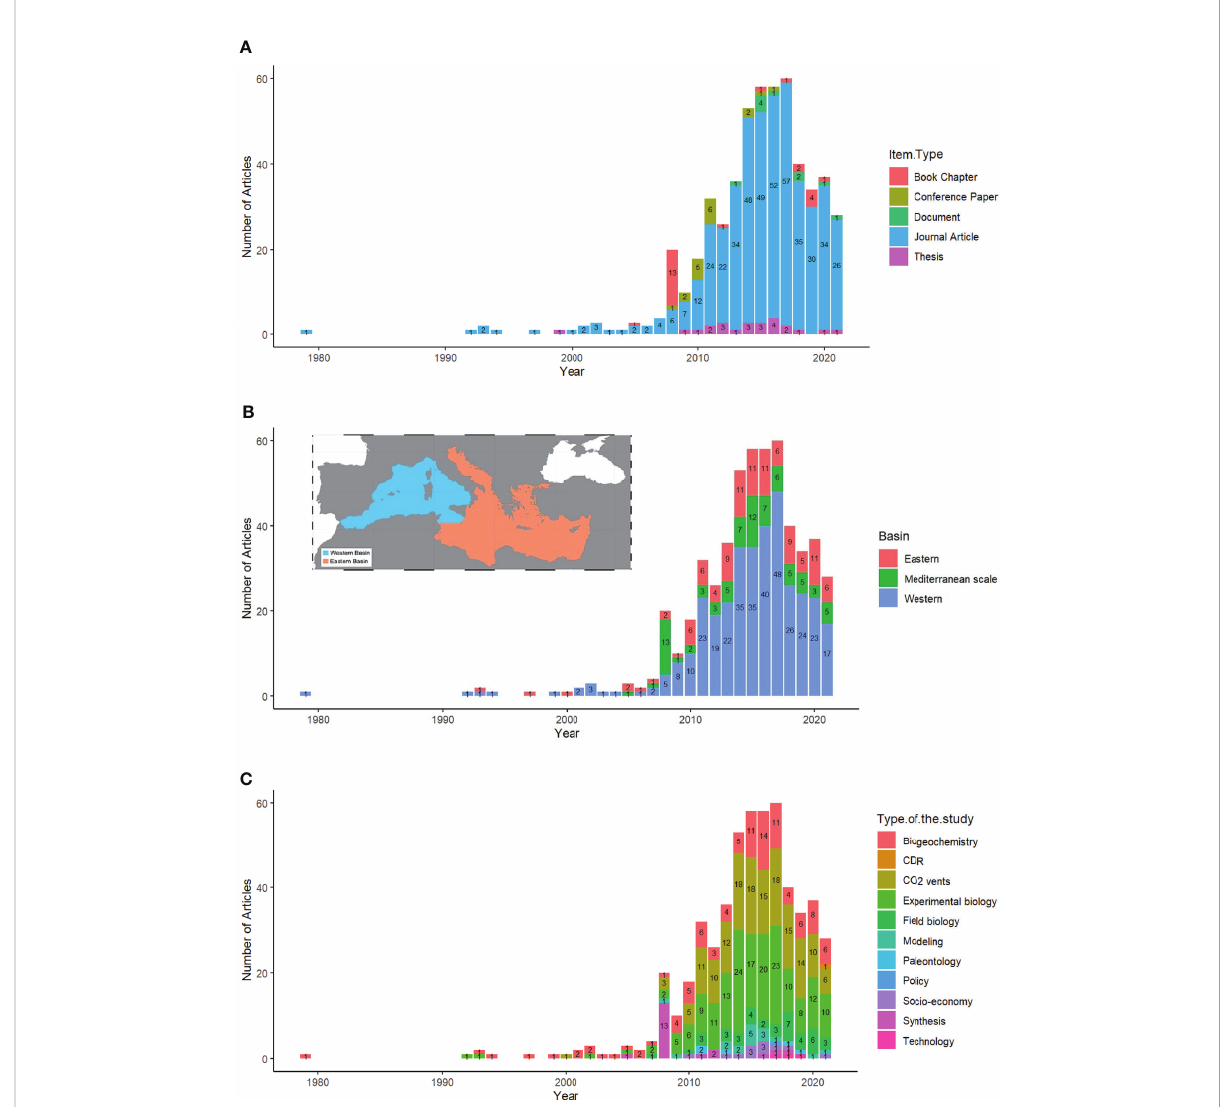
FIGURE 2 The evolution of OA-related publications through years in the Mediterranean: (A) showing the various types of OA-related items, (B) studies conducted in the main units of the Mediterranean basin, (C) the different types of OA